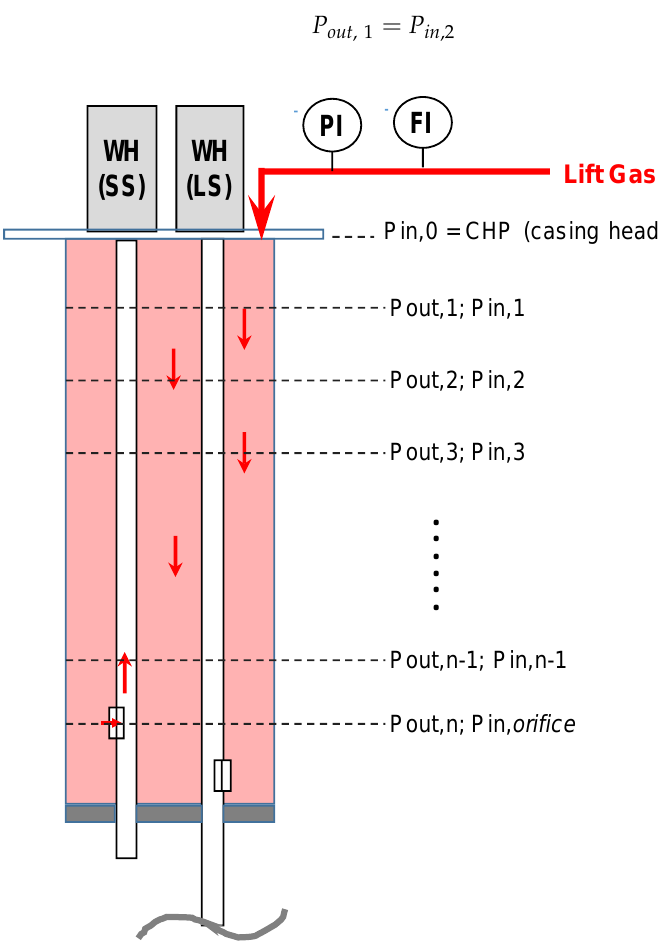
Figure 6. Division of pipe (annulus) section into smaller nodes in VBA.